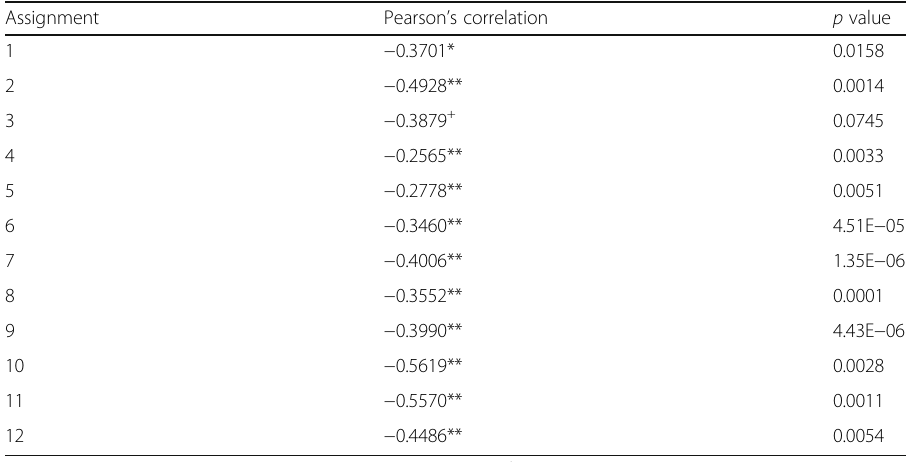
Table 2 Correlation analysis between the number of violated constraints and the occurrence frequency of the products Assignment Pearson ’ s